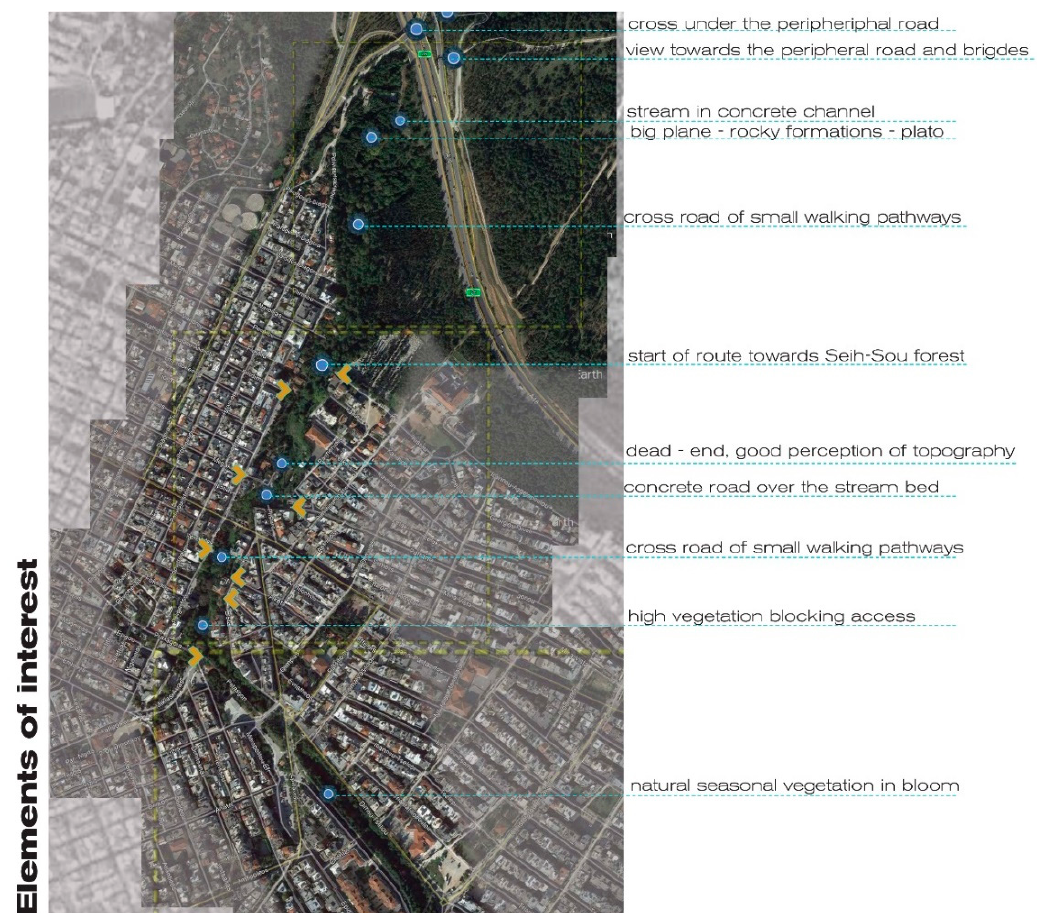
Figure 4. Stream Polygnotou, Points of interest. Source: